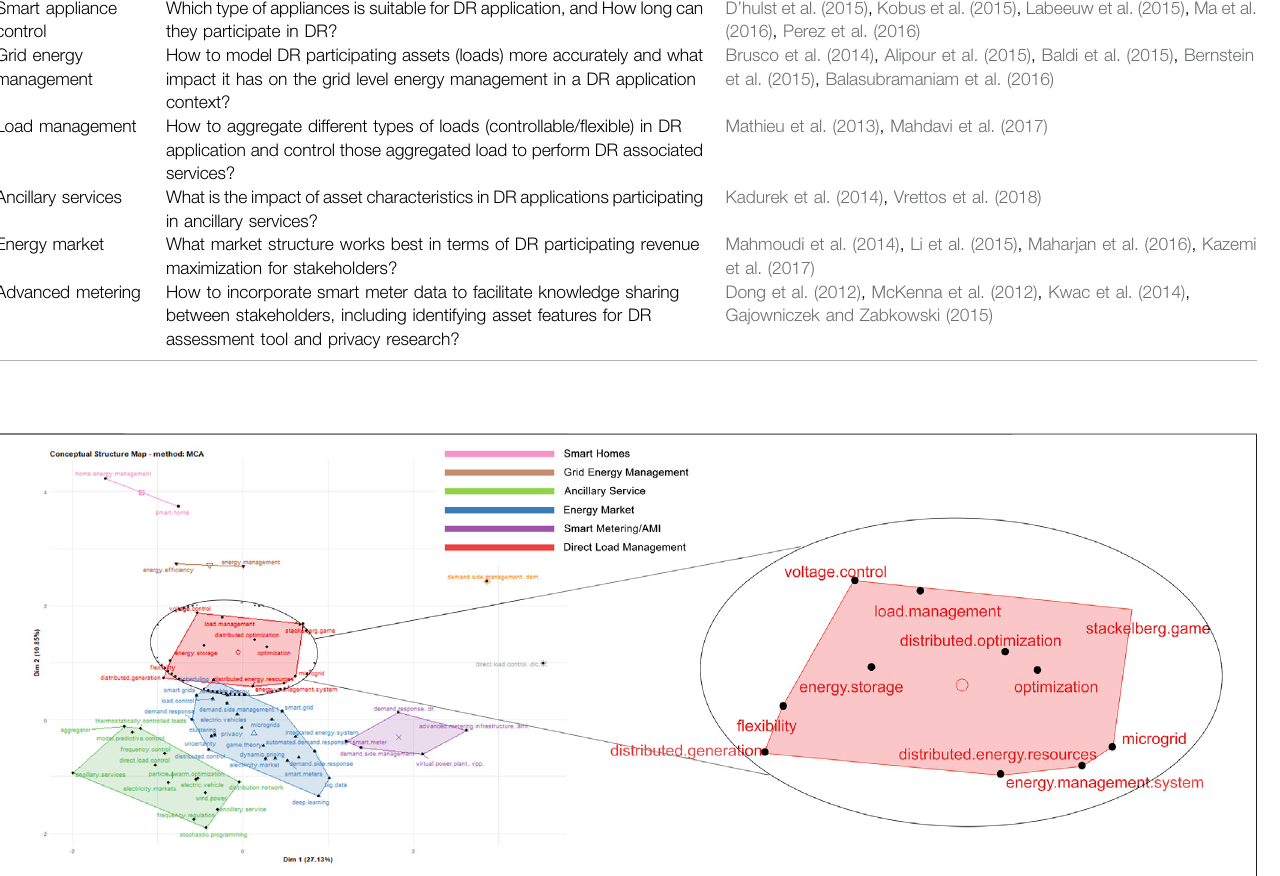
Frontiers in Energy Research |